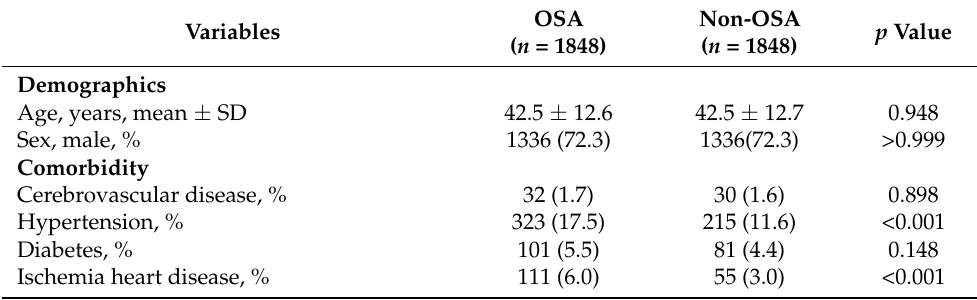
Table 1. Demographics and clinical characteristics of patients in the non-OSA and OSA groups ( n =